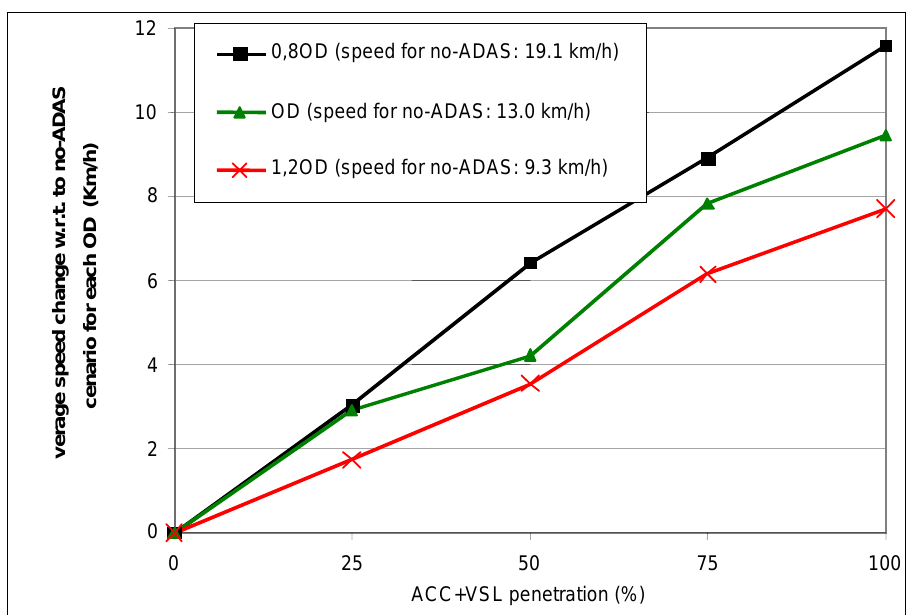
Figure 4. Combined ACC and VSL network efficiency